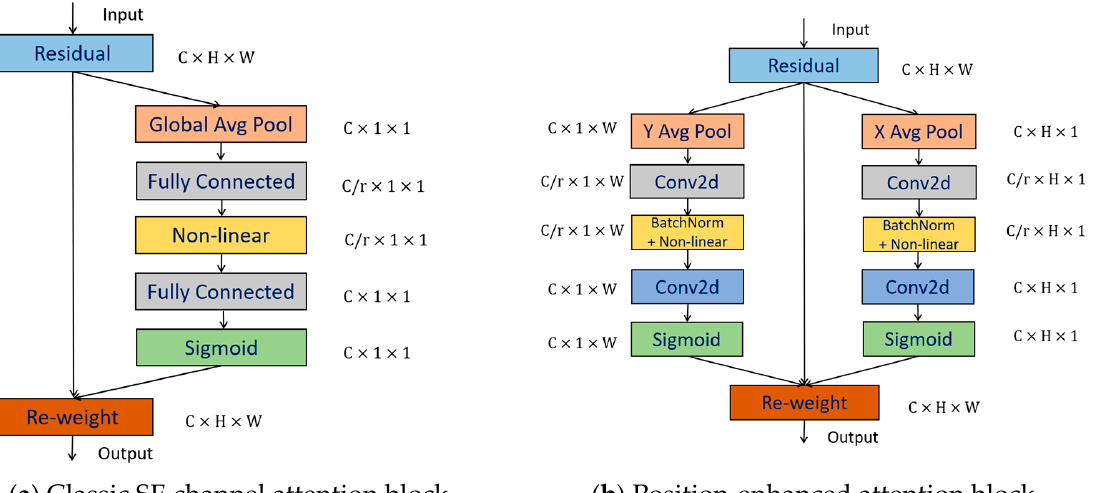
Figure 4. Structural contrast of the classic SE channel attention block and the position-enhanced attention block.